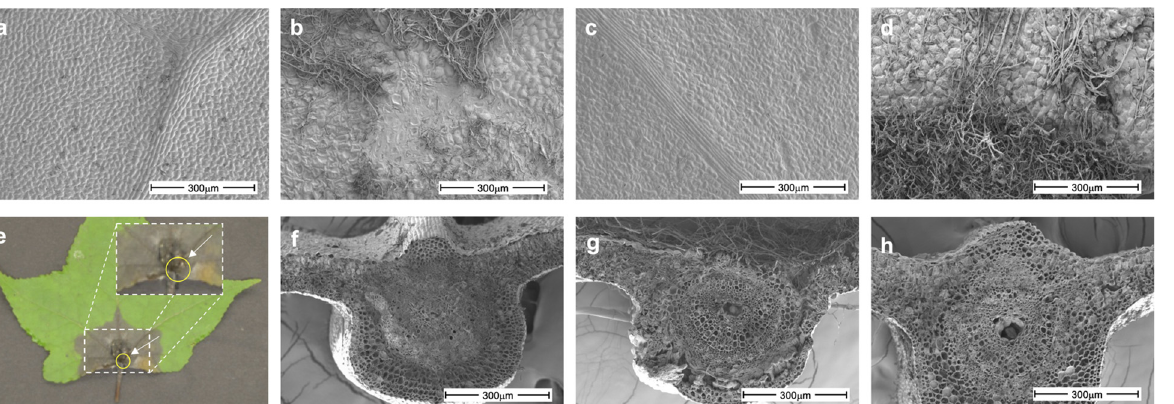
Figure 4. Analysis by scanning electron microscopy of L. styraciflua leaves infected with N. parvum . ( a , c ) Control adaxial leaves at 3 and 8 dpi, respectively. ( b , d ) Infected axial leaves at 3 and 8 dpi, respectively. ( e ) Leaf base infection: the dashed squares indicate the zones that were analyzed in ( f – l ). ( f , h ) Control at 3 and 8 dpi, respectively. ( g ) Infected sample at 3 dpi. ( i – l ) Infected sample at 8 dpi. ( j , k ) Close ‐ ups of panel ( i ). The pycnidia are delimited with a solid yellow line. Arrows indicate the pycnidium and conidia of N. parvum . Finally, since the Botryosphaeriaceae family members are characterized as woody ‐ plant pathogens, the pathogenicity of the Liqui 1–3 strain on fresh stems of L. styraciflua was tested. As shown, N. parvum at 7 dpi triggered distinct symptoms of disease, includ ‐ ing discoloration and necrosis, covering a zone beyond the site of inoculation (Figure 5). Figure 5. Infection of L. styraciflua fresh stems with N. parvum . The photographs were taken at 7 dpi. 3.3. Identification and Description of CysRPs in L. styraciflua and N. parvum CysRPs have been widely studied for their important functions in plant–pathogen interactions, in both the host and pathogen. To identify CysRPs in L. styraciflua and N. parvum , two databases with transcriptomic and genomic information were analyzed. For Control + N. parvum